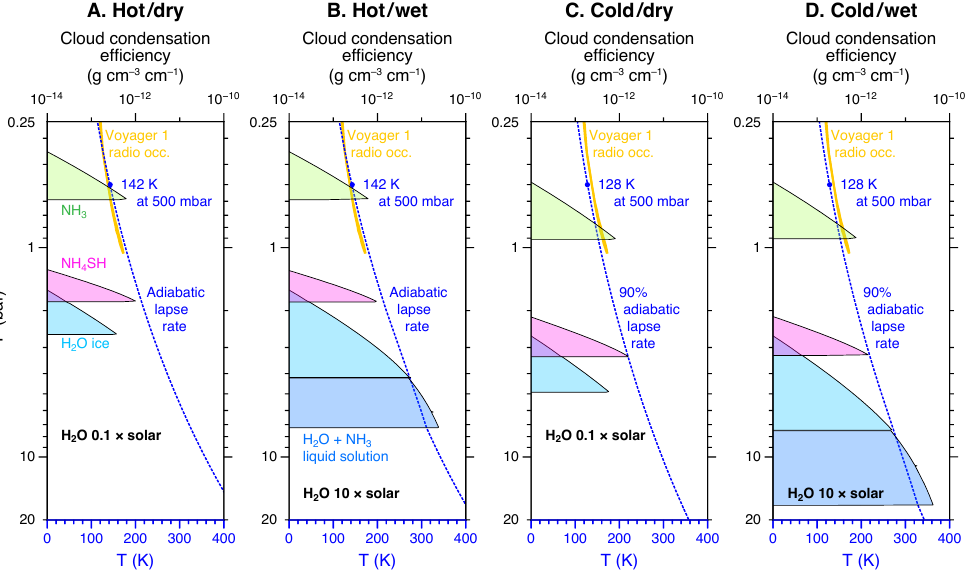
Figure 16. The sensitivity of cloud base pressure to volatile abundance has been widely discussed in the literature. However, water cloud base levels—for the same water abundance—also vary by a factor of two between the end-member temperature structures. For example, the water cloud base for a 10 × solar H 2 O abundance is 7.5 bar for a hot end-member temperature profile (panel B ) and 17 bar for a cold end-member temperature profile (panel D ). For 1 × solar H 2 O, the cloud base for hot and cold conditions ranges from 3.8 to 7.7 bar. The Voyager 1 radio occultation profiles [121] are shown for comparison (ingress and egress profiles overlap at this